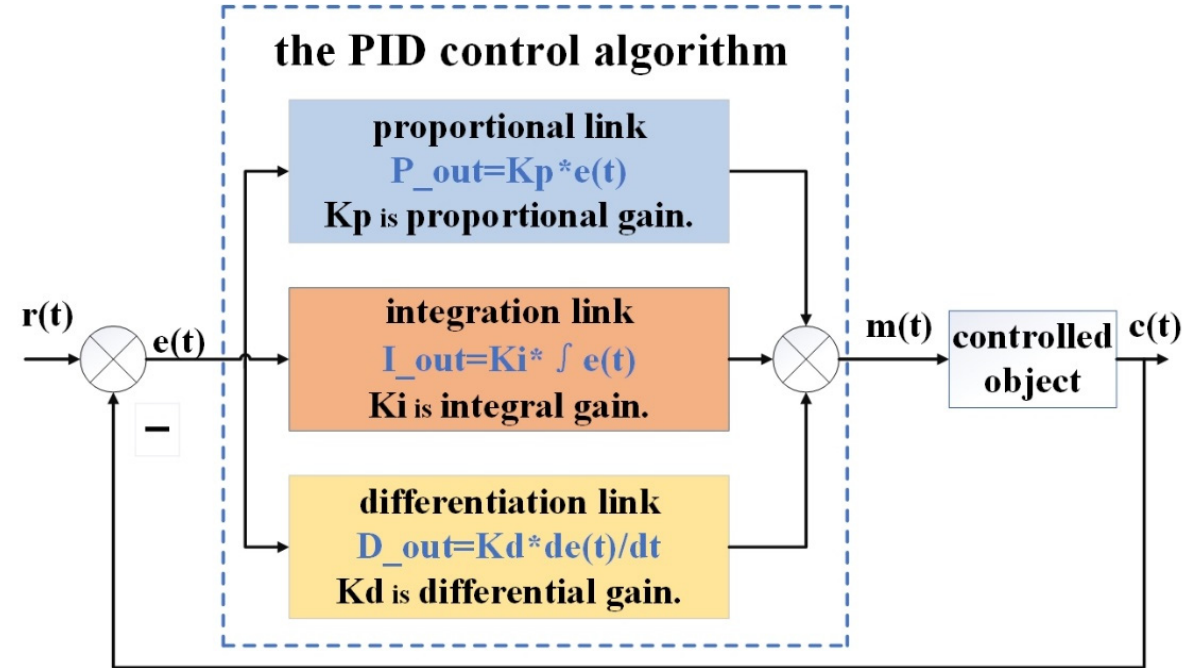
Figure 1. The basic model of the PID control algorithm.